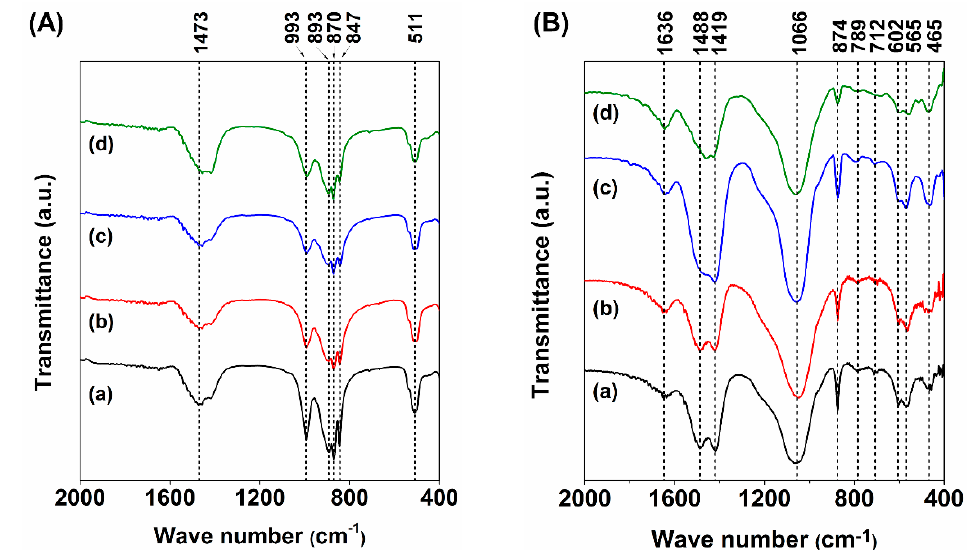
Figure 8. FTIR of C2S and Sr-C2S bone cement before ( A ) and after ( B ) immersion in SBF solution for 7 days: ( a ) C2S; ( b ) Sr1-C2S; ( c ) Sr5-C2S; ( d ) Sr10-C2S. The interpretation of different absorption peaks is as follows: ( A ) 1474 cm − 1 and 870 cm − 1 —CO 32 − , the absorption band between 893 cm − 1 to 847 cm − 1 and the absorption peaks 993 cm − 1 and 511 cm − 1 —Si-O-Si; (B) 1636 cm − 1 and 789 cm − 1 —H 2 O, 1488 cm − 1 , 1419 cm − 1 , 874 cm − 1 and 712 cm − 1 —CO 32 − , 465 cm − 1 —Si-O-Si, 1066 cm − , 602 cm − 1 and 565 cm − 1 —PO 43 − . It can be clearly seen that phosphate salts formed on the surface of the cements after immersion in SBF solution.